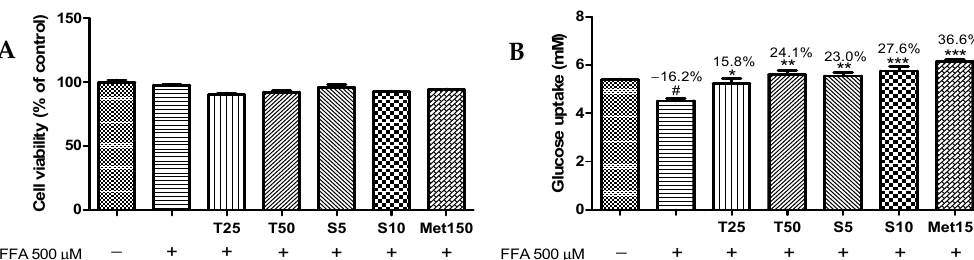
Figure 2. Effects of taxifolin and sorghum ethanol extract on ( A ) cell viability and ( B ) glucose uptake in HepG2 cells. Data are presented as the mean ± standard error (n = 3). # p < 0.05 versus the control cells; * p < 0.05, ** p < 0.01, and *** p < 0.001 versus the FFA-treated group. FFA, free fatty acid; T, taxifolin ( μ M); S, sorghum ethanol extract ( μ g/mL); Met, metformin ( μ M).